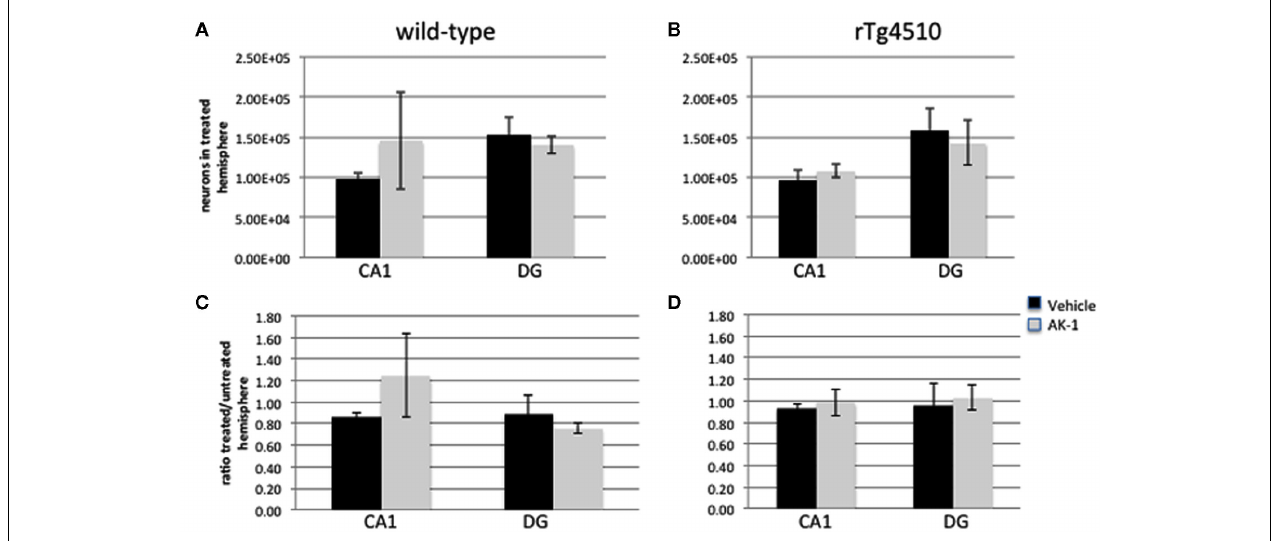
FIGURE 2 |AK1 delivery to the hippocampus is non-toxic. AK1 administration from 4 to 5.5months of age does not cause neurodegeneration in wild-type (A) or rTg4510 hippocampus (B) . Placement of the cannula in the treated hemisphere does not cause unilateral neuron loss in wild-type (C) or rTg4510 (D)